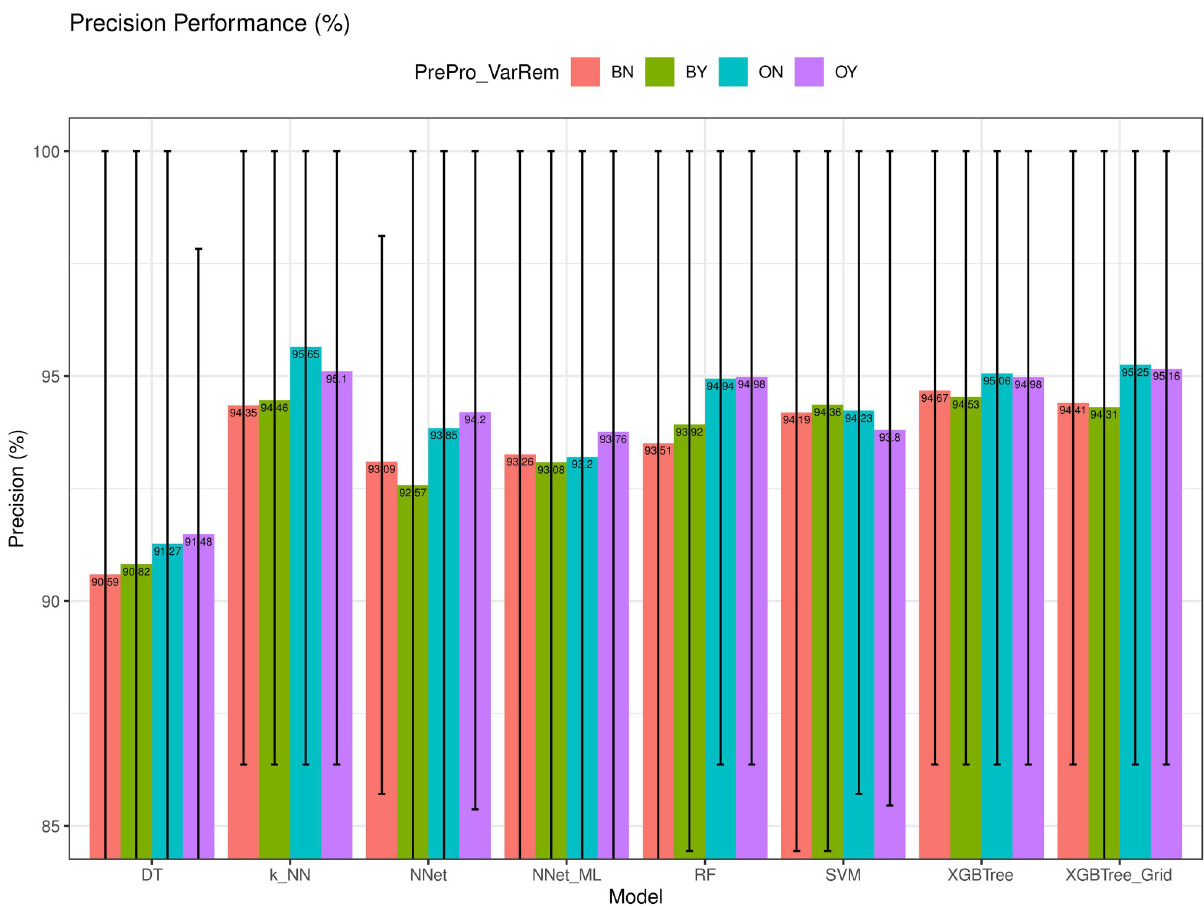
Fig 12. Precision ( Pre ) of different